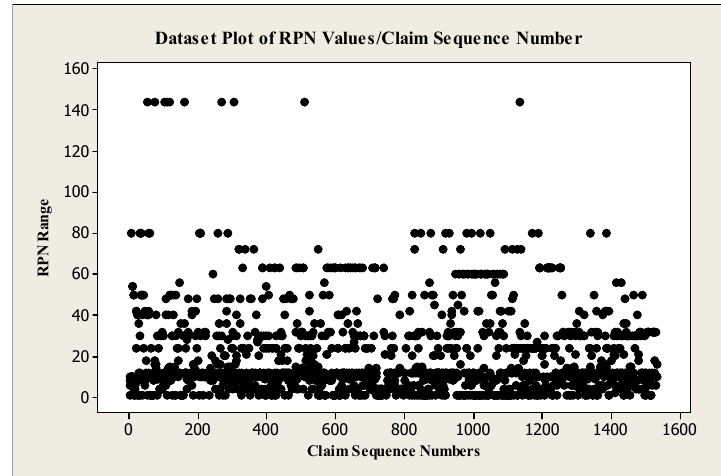
Figure 6. Dataset plot of all claims based on RPN value.